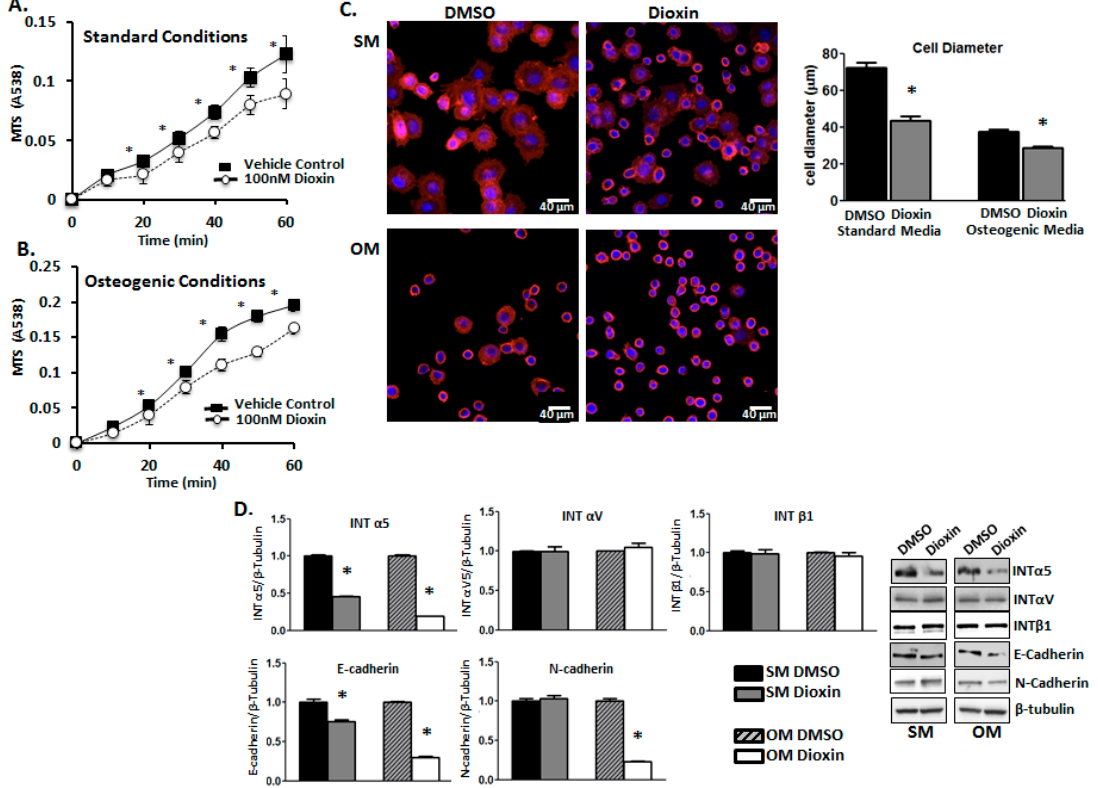
Figure 3. Dioxin reduces cell adhesion in both un-induced and differentiating MG-63 cells. Cell adhesion rates were quantified after a dioxin pre-treatment period of 3 days under either standard ( A ) or osteogenic conditions ( B ). Significance is shown relative to vehicle control-treated cells under both standard and osteogenic conditions; ( C ) Visualization of cell morphology. Dioxin exposure significantly decreased the proportion of flattened cells under both standard and osteogenic conditions, whereas the proportion of rounded cells was increased in response to dioxin treatment. Rhodamine-bound F-actin is shown in red, whereas nuclei are shown in blue; ( D ) Integrin (INT) α 5 and E-cadherin protein expression levels were significantly decreased in dioxin-exposed cells under both standard and osteogenic conditions, whereas INT α V and INT β 1 were unchanged. N-cadherin levels were decreased only in differentiating dioxin-treated cells. * p < 0.05 relative to 0 nM dioxin under standard or osteogenic conditions. Error bar means ± SEM.